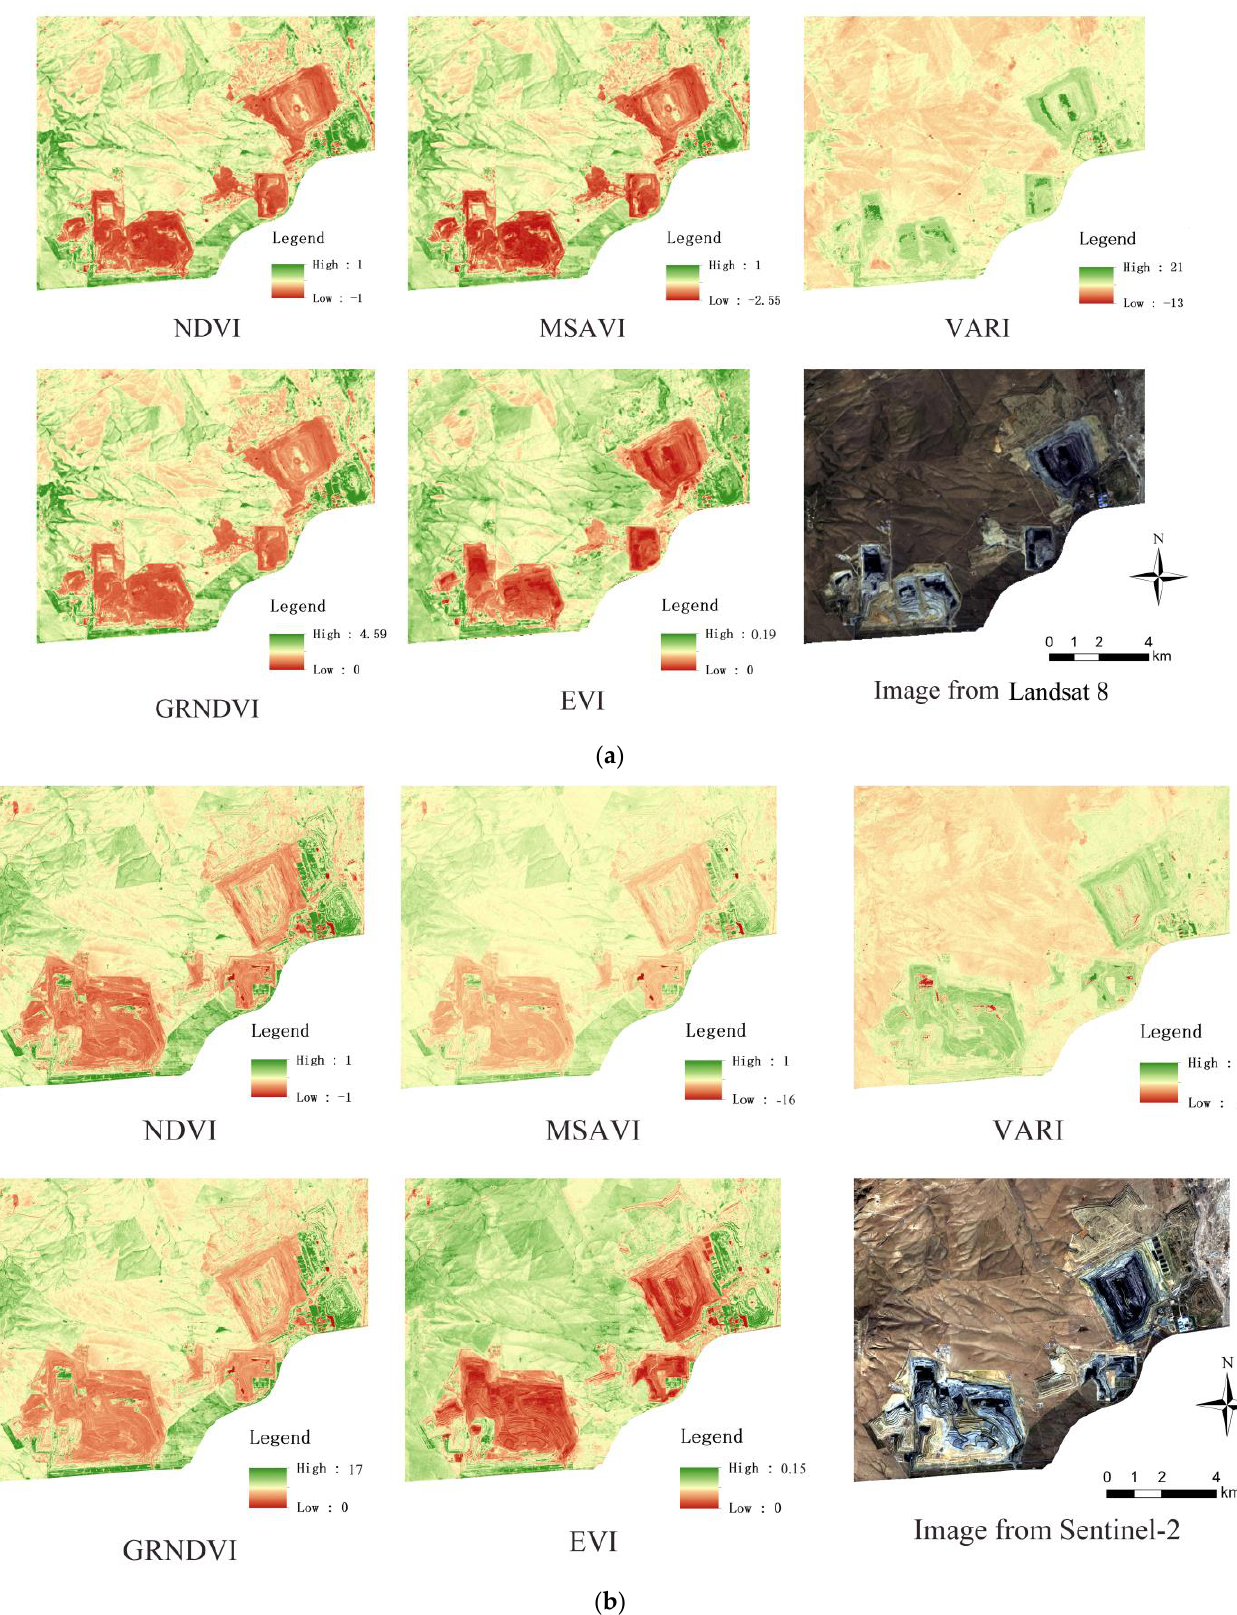
Figure 3. Part of the results of the vegetation index test. ( a ) The vegetation index is calculated from Landsat data in 2015, ( b ) The vegetation index is calculated from Sentinel-2 data in 2019.